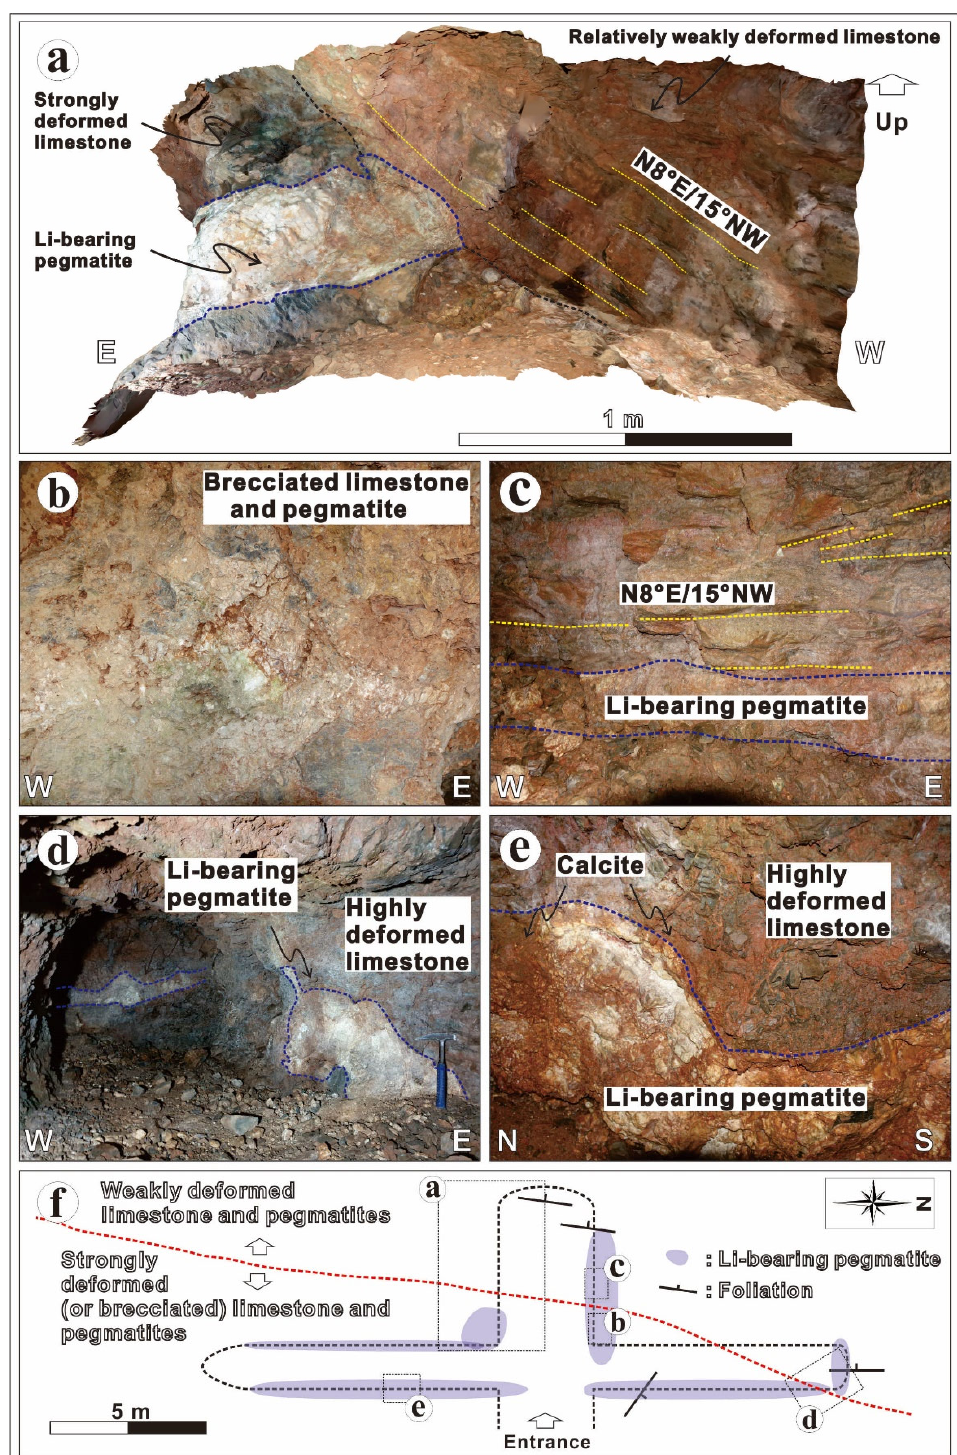
Figure 11. Rare ‐ element pegmatite (REP) body Pgt 9 developed at a small pit. ( a ) Pgt 9 developed in strongly deformed limestone and its extension is controlled by the bedding of weakly deformed limestone. ( b , c ) Although the rocks were on the same wall, a difference in the degree of deformation was observed. ( d , e ) In the N–S plane, strongly deformed rocks were observed, whereas in the E–W plane, relatively weakly deformed rocks were observed. ( f ) The location of each figure is marked on the simplified map of the pit. NNE–SSW-trending lines were inferred based on the differences in the degree of